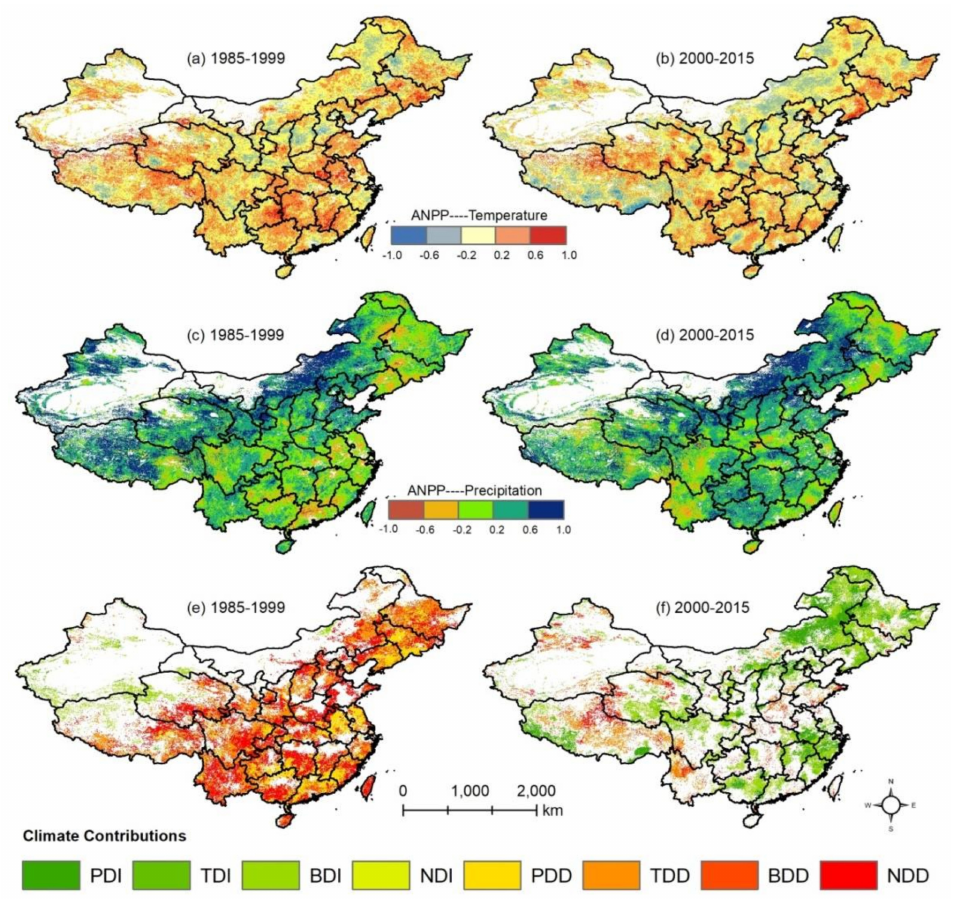
Figure 16. Correlation-based contributions of temperature and precipitation: ( a , b ) the correlations between ANPP and temperature; ( c , d ) the correlation between ANPP and precipitation; ( e , f ) the individual contributions of temperature and precipitation for the base and restoration periods, respectively.